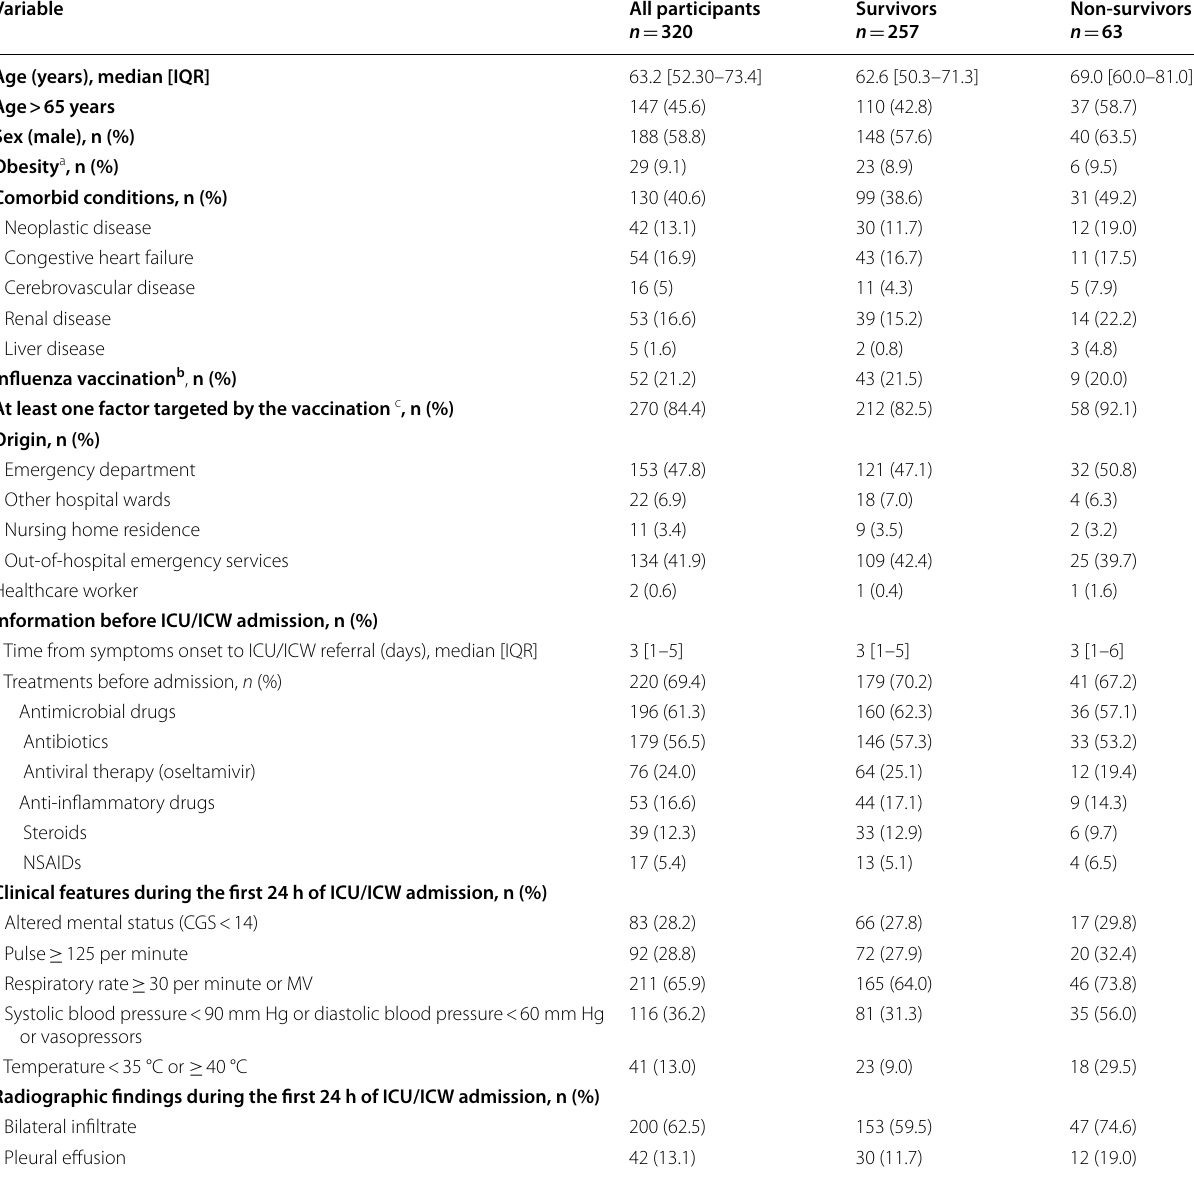
Table 1 Characteristics of the population on ICU/ICW